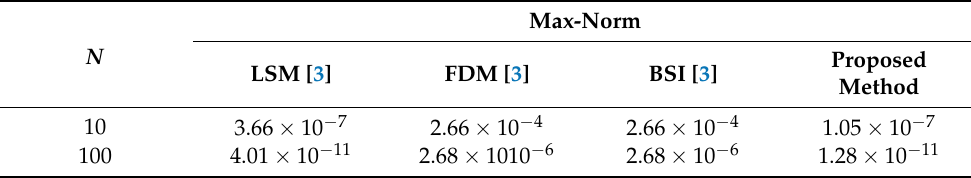
Table 5. Comparison of maximum errors for Problem